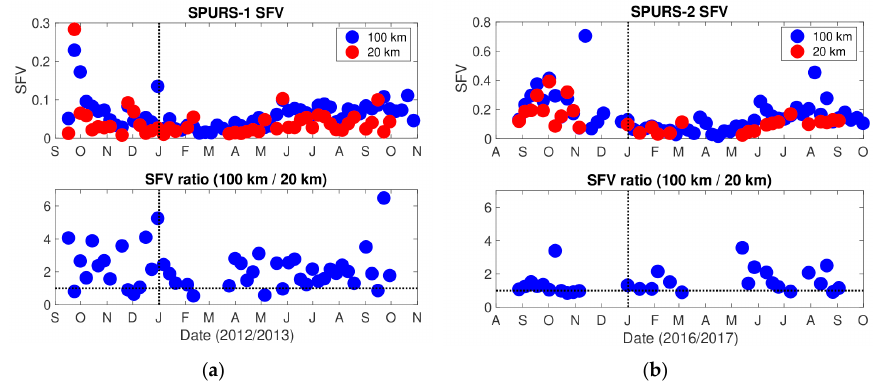
Figure 1. Time series of SFV in the SPURS regions. Top panels: Blue markers are SFV using a 100 km footprint size. Red markers use a 20 km footprint. Bottom panels: Ratio of 100 km to 20 km SFV. That is, the ratio of the blue markers in the top panels to the red markers. The horizontal dashed line indicates where this ratio is 1. ( a ) SPURS-1; ( b ) SPURS-2. Note vertical axes are not consistent between the top panels.